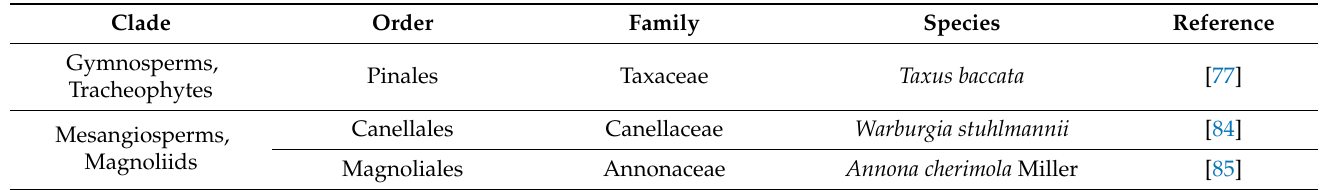
Table 1. Plant species containing pure kaempferol